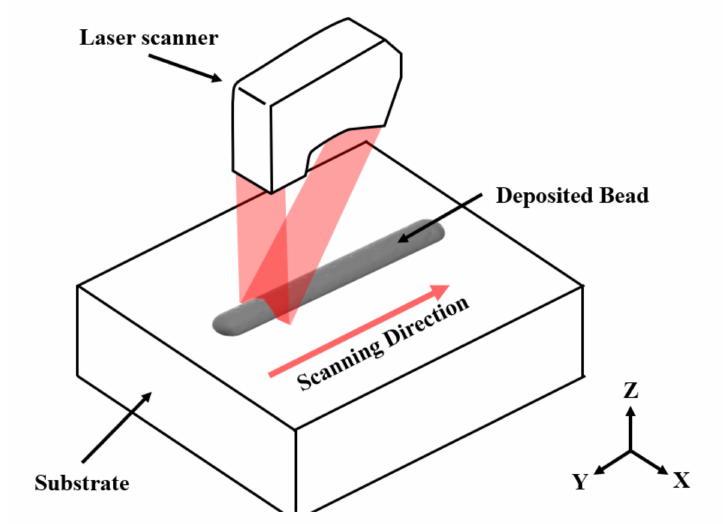
Figure 6. 3D triangulation method using a laser scanner. The width and height of the deposited bead were measured.